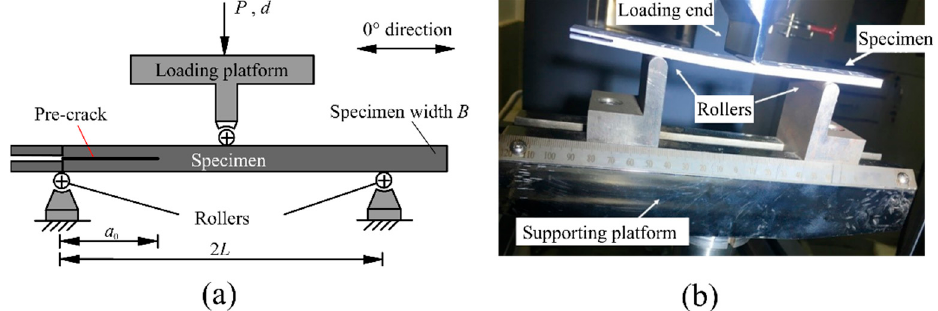
Figure 1. ( a ) Schematic diagram and ( b ) picture of the ENF test set-up.